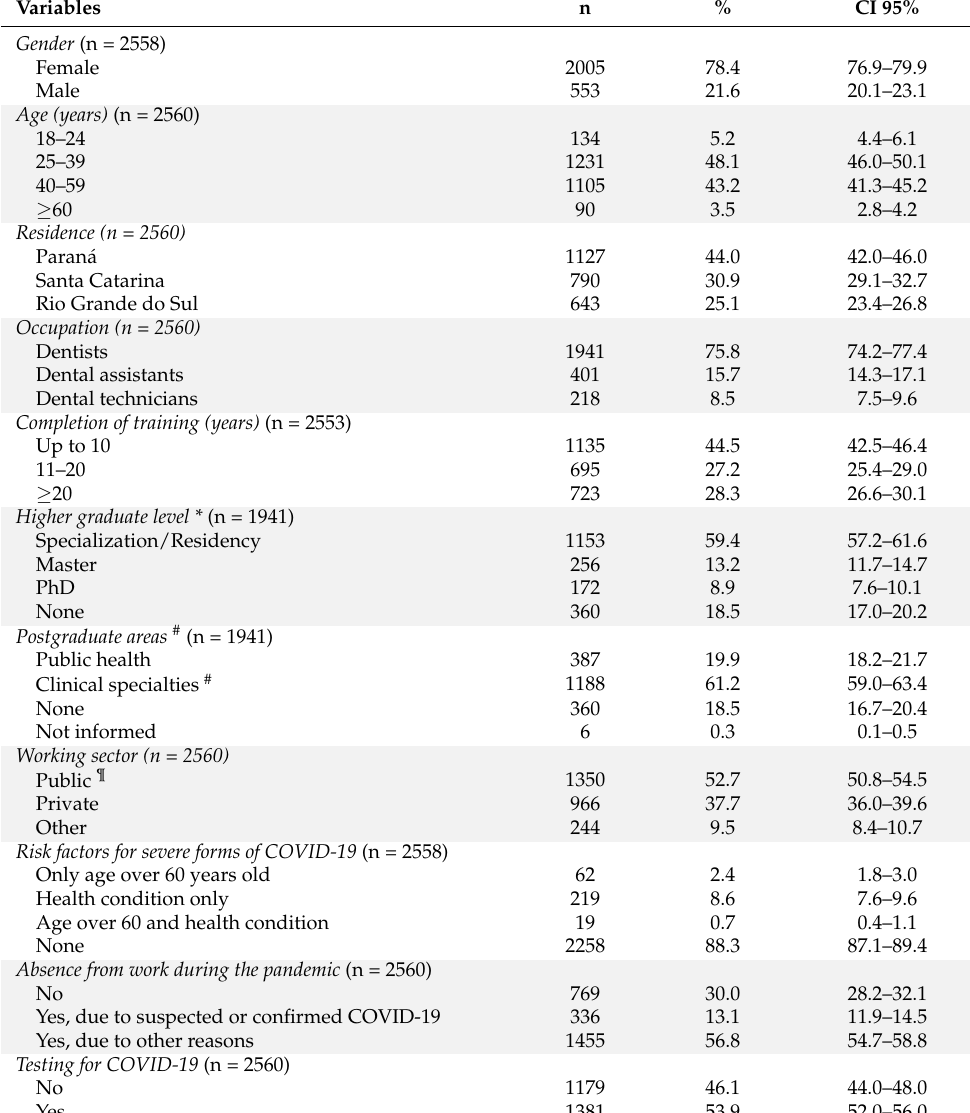
Table 1. Sociodemographic, education, work, and health characteristics of the sample of oral health care workers from Brazil, August–October, 2020. Variables n